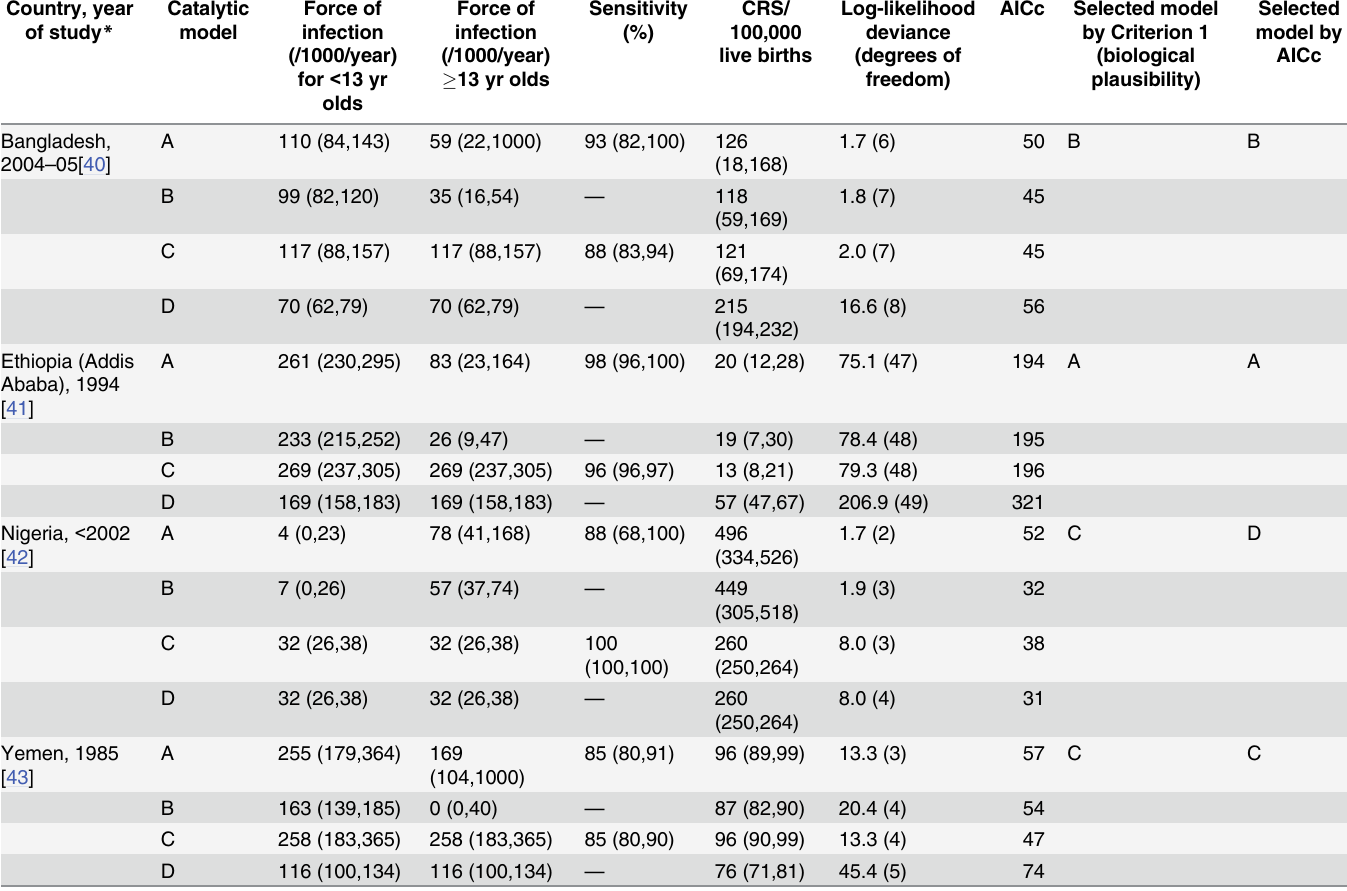
Table 4. Examples of the results obtained by fitting the catalytic models to data. The best-fitting values for the force of infection and (where appropriate) the sensitivity of the antibody assay, and the CRS incidence per 100,000 live births for each catalytic model The values in parentheses reflect the 95% confi- dence intervals, obtained by bootstrapping. To facilitate comparisons, the infection and CRS incidence is not weighted by the number of live births. Country, year of study